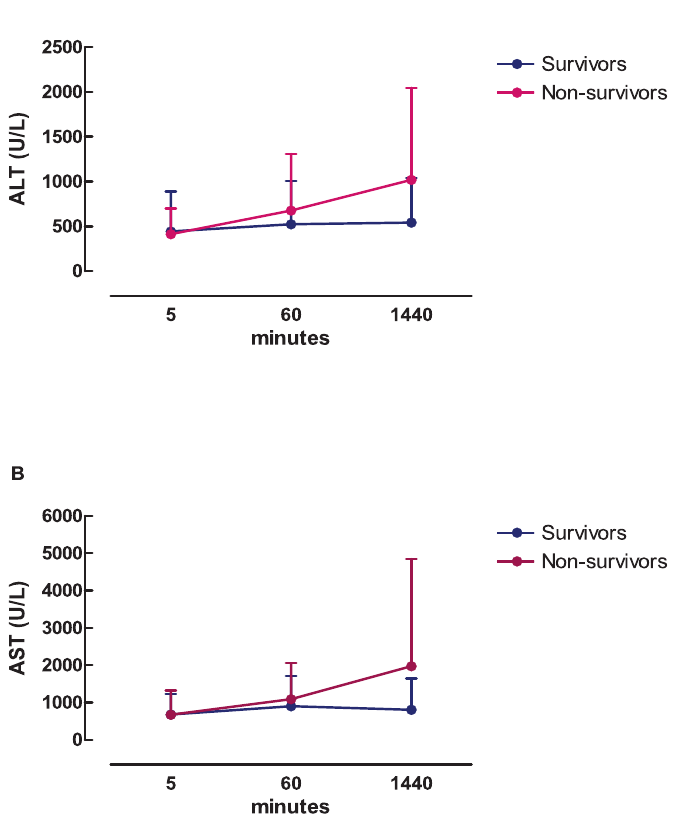
FIGURE 2 - Aminotransferase values, ALT (panel A) and AST (panel B), at 5, 60 and 1440 minutes after arterial graft revascularization of patients of the survivor and non-survivor groups.